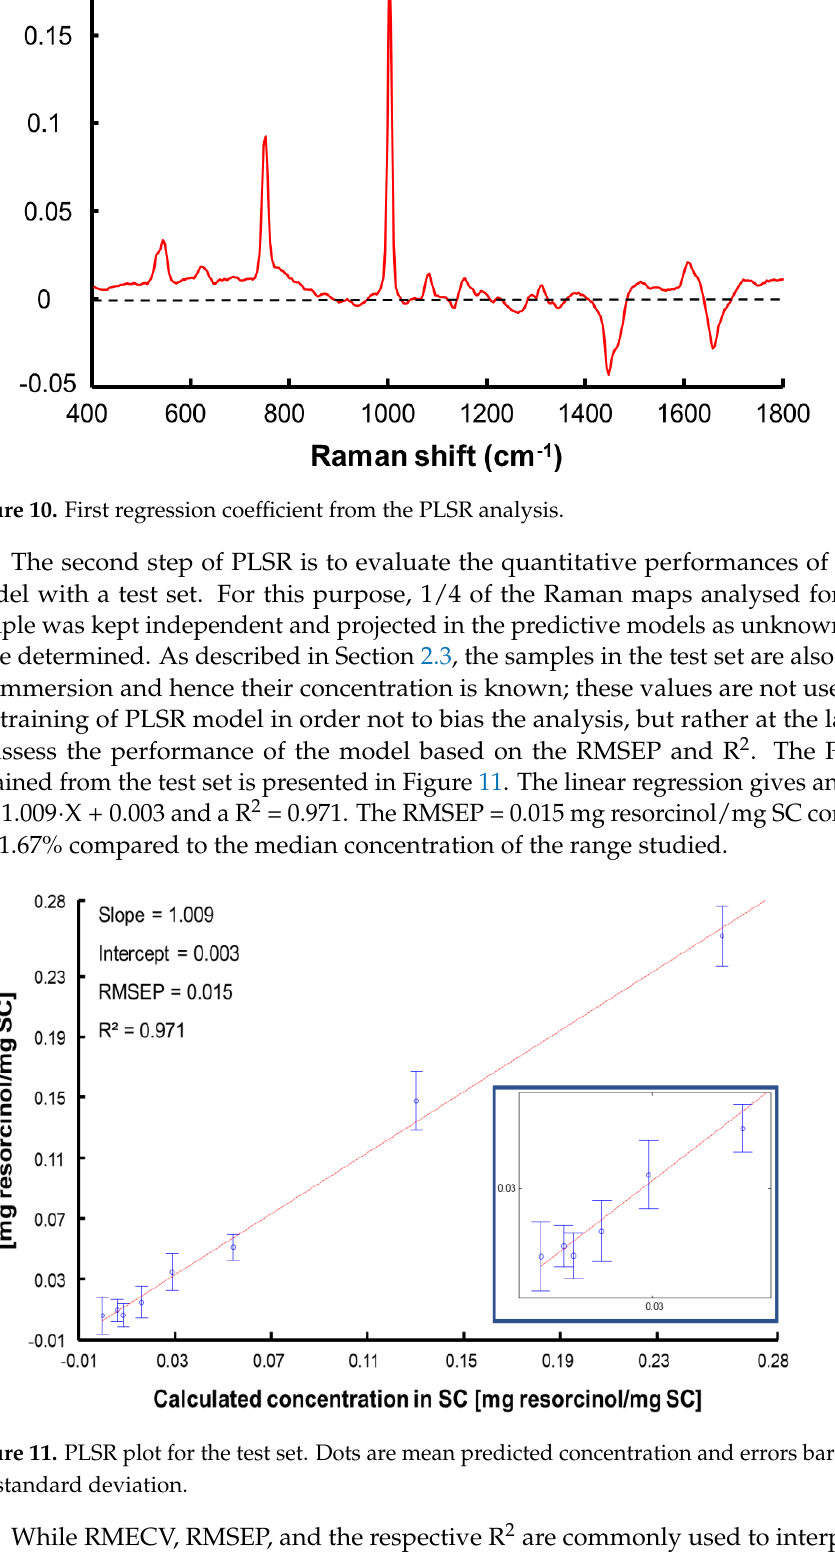
Figure 9. PLSR plot for the validation set. Dots are mean predicted concentration and errors bar represent the standard deviation.